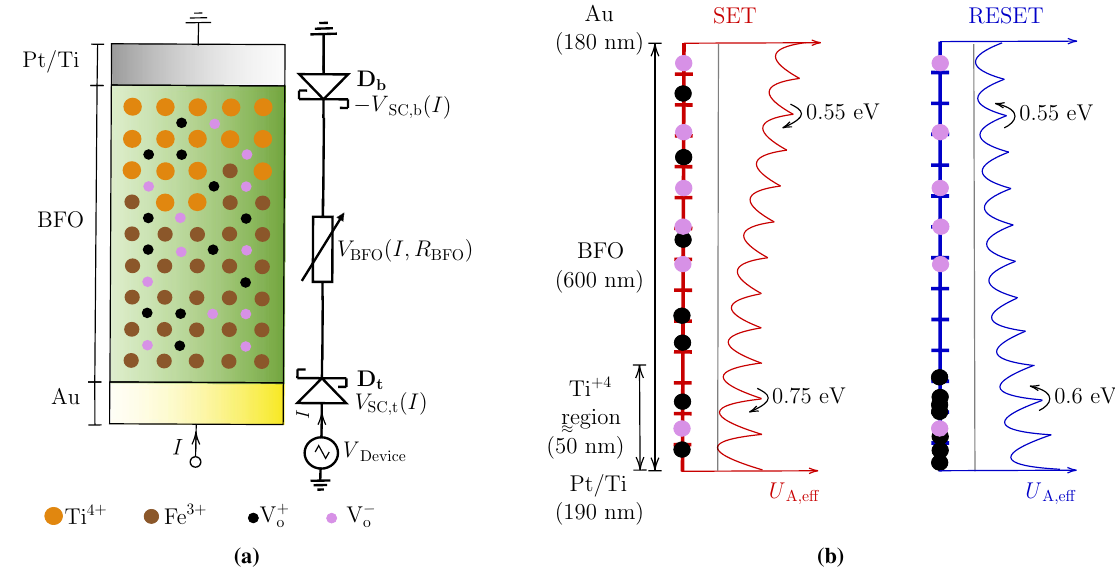
Figure 2. Simulation scenario of BFO memristor. ( a ) A Au / BiFeO 3 ( BFO )/ Pt / Ti memristive device and it’s equivalent circuit with back-back schottky diodes and a variable resistor. ( b ) Ion transport and the potential structure across a 1D BFO memristor for set and reset